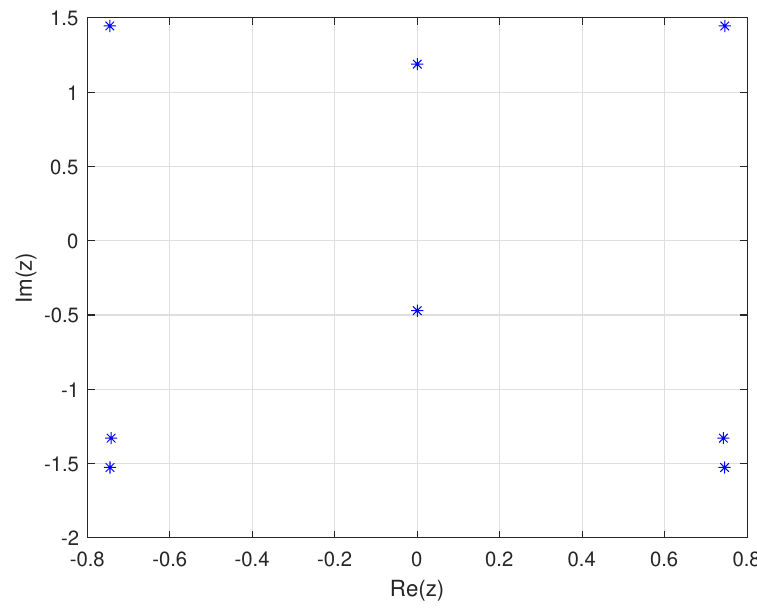
Figure 7 . The distribution of roots { z l } at a low-lying excited state for N = 9 and η = 0 . 75 + iπ